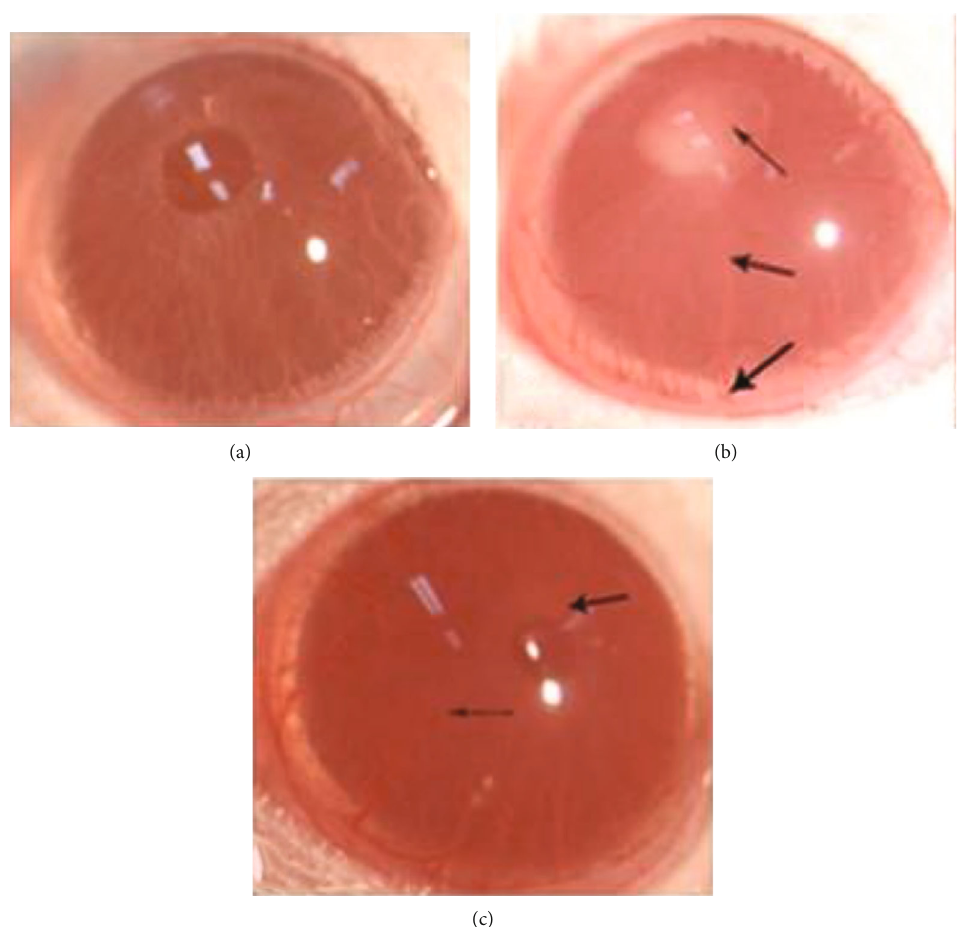
Figure 1: Clinical signs of anterior segment. (a) No signs of in fl ammation were observed in the NC group. (b) In the EIU group, we observed obvious closed pupil membrane (the top arrow), iris blood vessels dilation (the middle arrow), and purulent exudate (the bottom arrow). (c) The iris blood vessels dilation (the arrow on the left) and the pupil constriction (the arrow on the right) were slighter in the ET group; no other obvious in fl ammation was found.